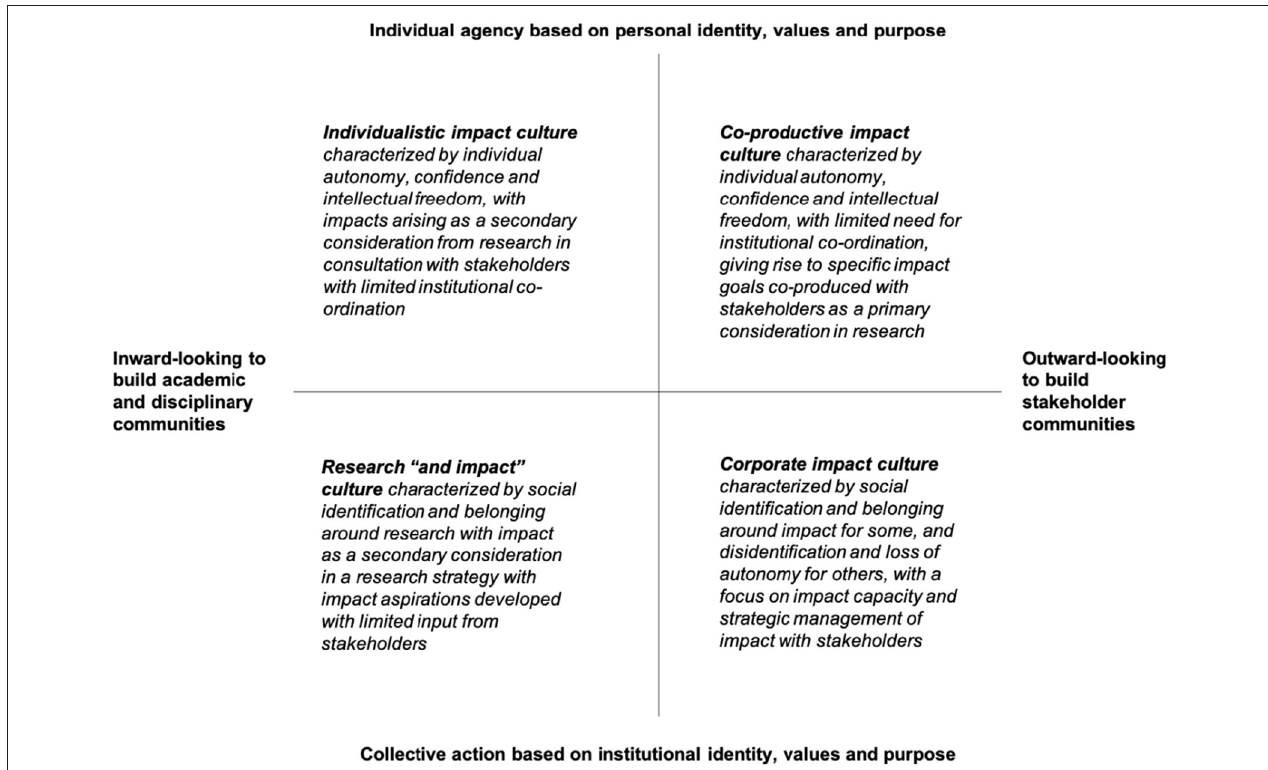
FIGURE 2 | Impact culture typology showing four types of impact culture arising from inward vs. outward looking approaches to community building and institutional vs. individualistic approaches to identity, values, and purpose around